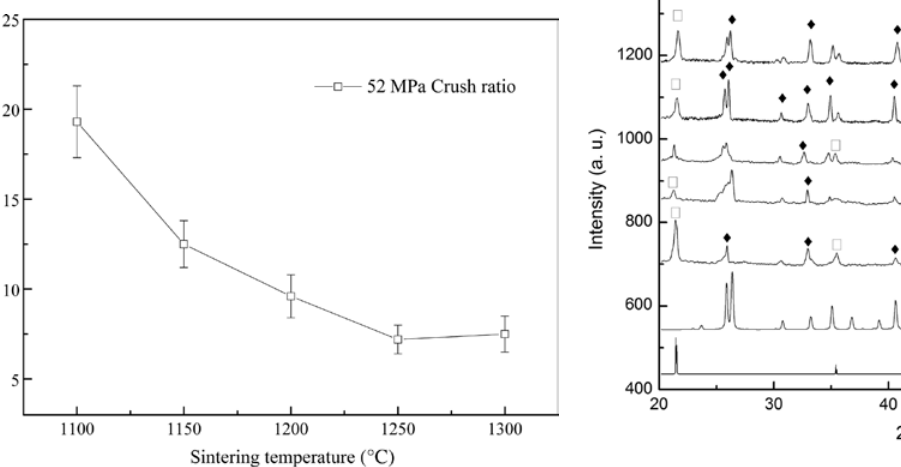
Figure 5: The XRD patterns of proppants at different sintering